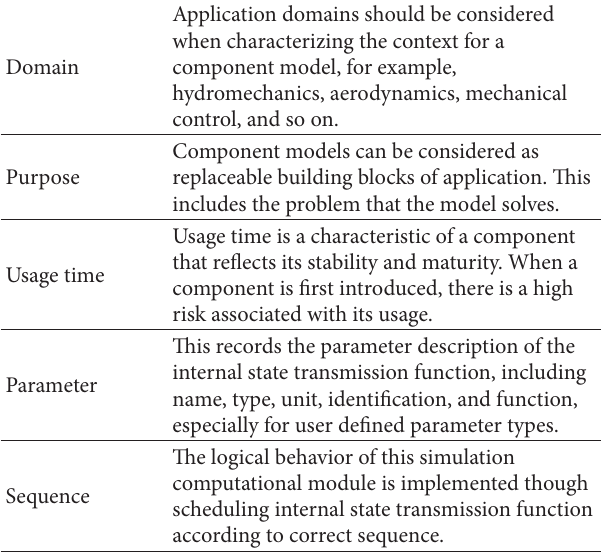
Table 1: Informal description of a computational